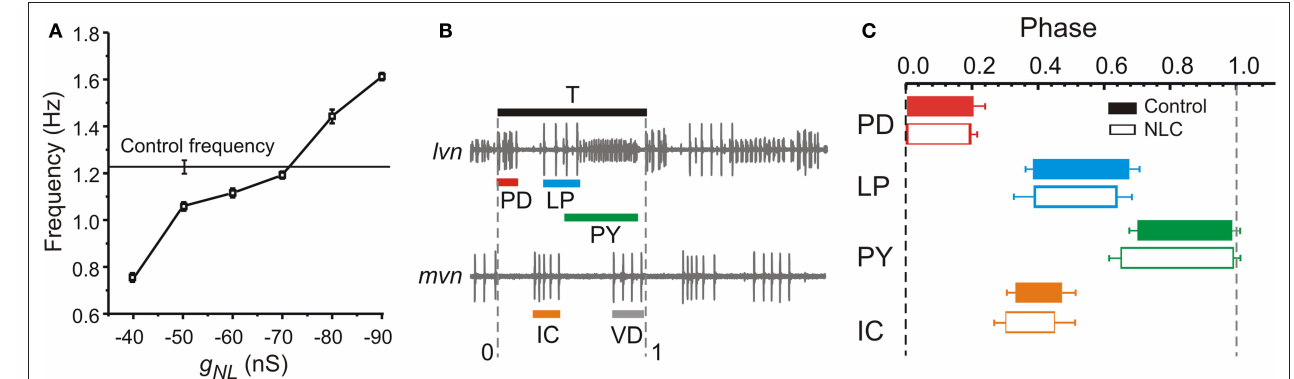
Figure  | effect of negative leak conductance on network frequency and phase relationships. (A) Negative leak conductance was injected into one PD neuron and the effect on rhythm frequency is plotted against the maximal conductance g . Control frequency before decentralization is indicated by the NL horizontal line ( ± SD). (B) Sample extracellular recordings of lvn and mvn used to determine the phase diagram shown in (C) . Black bar shows one period (T). Colored